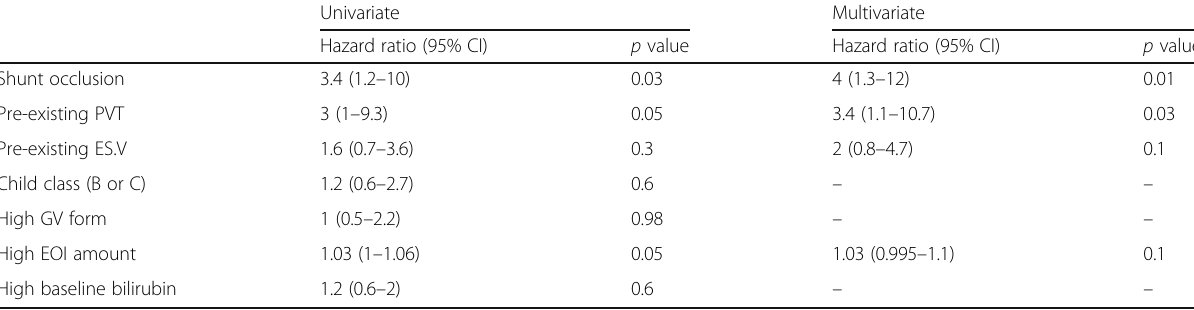
Table 3 Univariate and multivariate analysis of prognostic factors for Es.V aggravation after